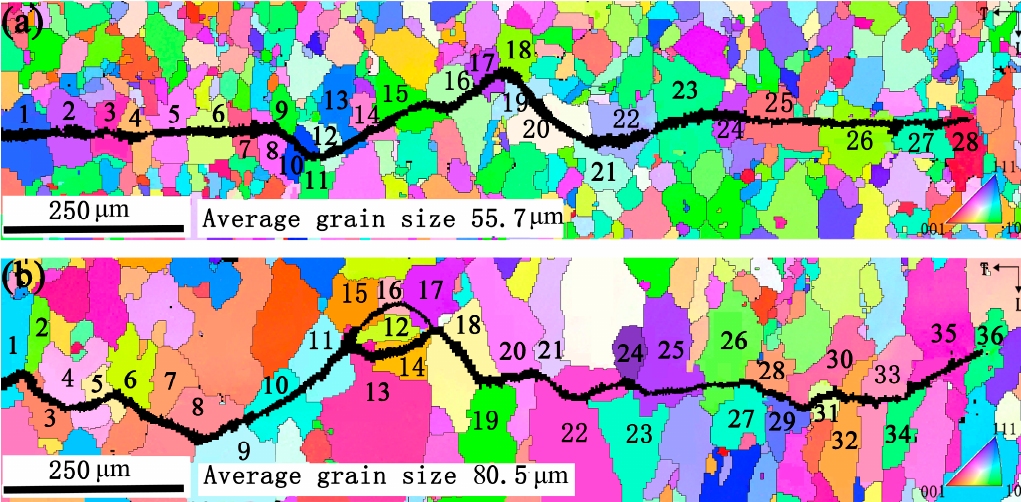
Figure 7. EBSD results showing fatigue crack propagating path for samples A ( a ) and B ( b ).